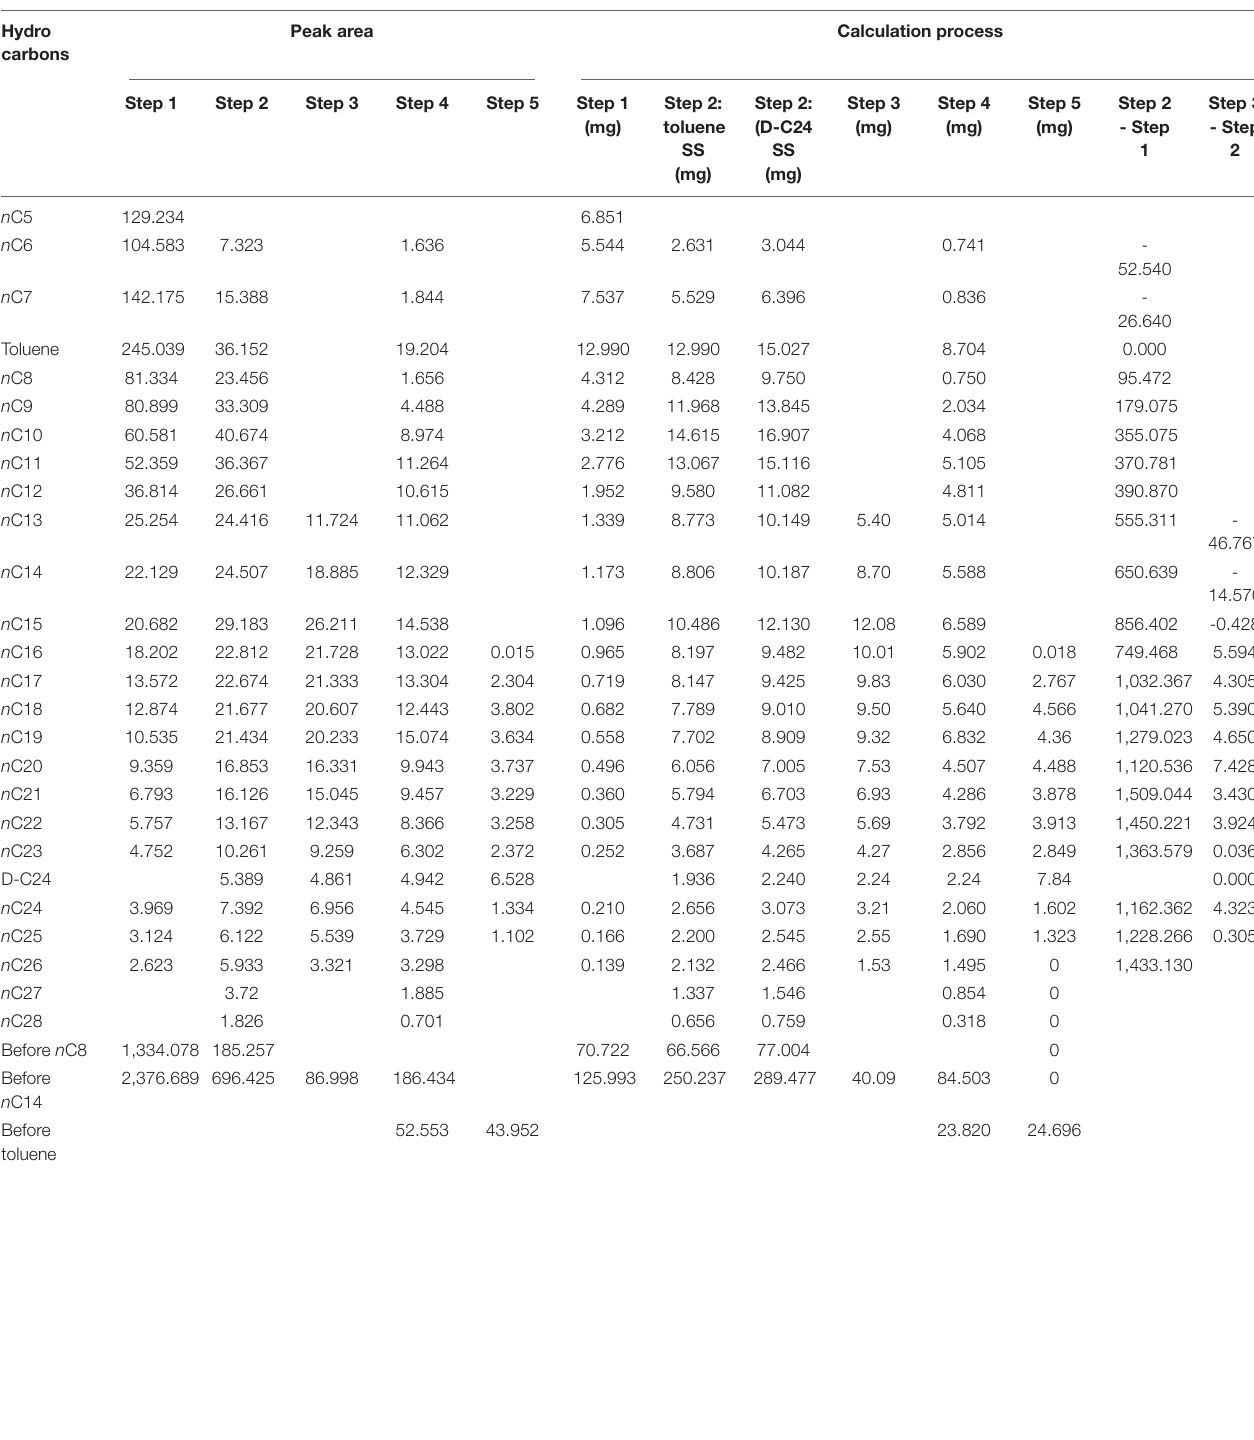
TABLE A1 | Typical chromatogram table of sample 6 and the calculation process. Hydro